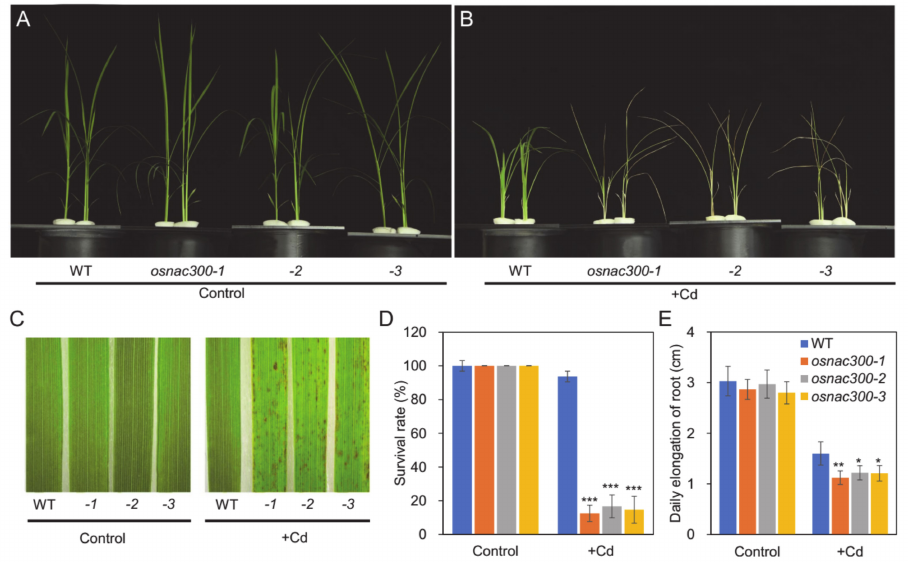
Figure 3. osnac300 mutants are hypersensitive to Cd stress. ( A , B ) Phenotype of osnac300 knockout lines subjected to Cd treatment. 2-week-old rice seedlings were grown on either control (1/2 Kimura solution) ( A ) or +Cd (+200 µ M CdCl 2 in 1/2 Kimura solution) ( B ) for 2 days, and subsequently restored in Cd-free solution for 5 days. ( C ) The images of leaves were taken when 2-week-old rice seedlings were grown under 200 µ M CdCl 2 for 2 days. ( D ) Survival rate of rice seedlings subjected to Cd treatments as described in ( A ). ( E ) Daily elongation of roots on the 3rd day of Cd stress. 3-d-old rice seedlings were grown on either control (0.5 mM CaCl 2 ) or +Cd (5 µ M CdCl 2 +0.5 mM CaCl 2 ) for 3 days. Mean values ± SD are shown. The values of the indicated genotypes were compared to that of the wild-type (WT) plants (Student’s t -tests, *** p <0.001, ** p <0.01, * p < 0.05, n = 12).